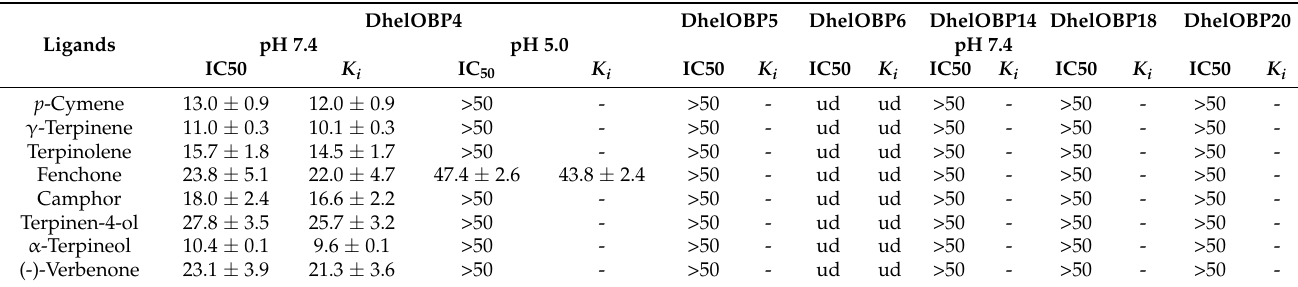
Table 3. IC50 and K i values of tested HIPVs to DhelOBPs.